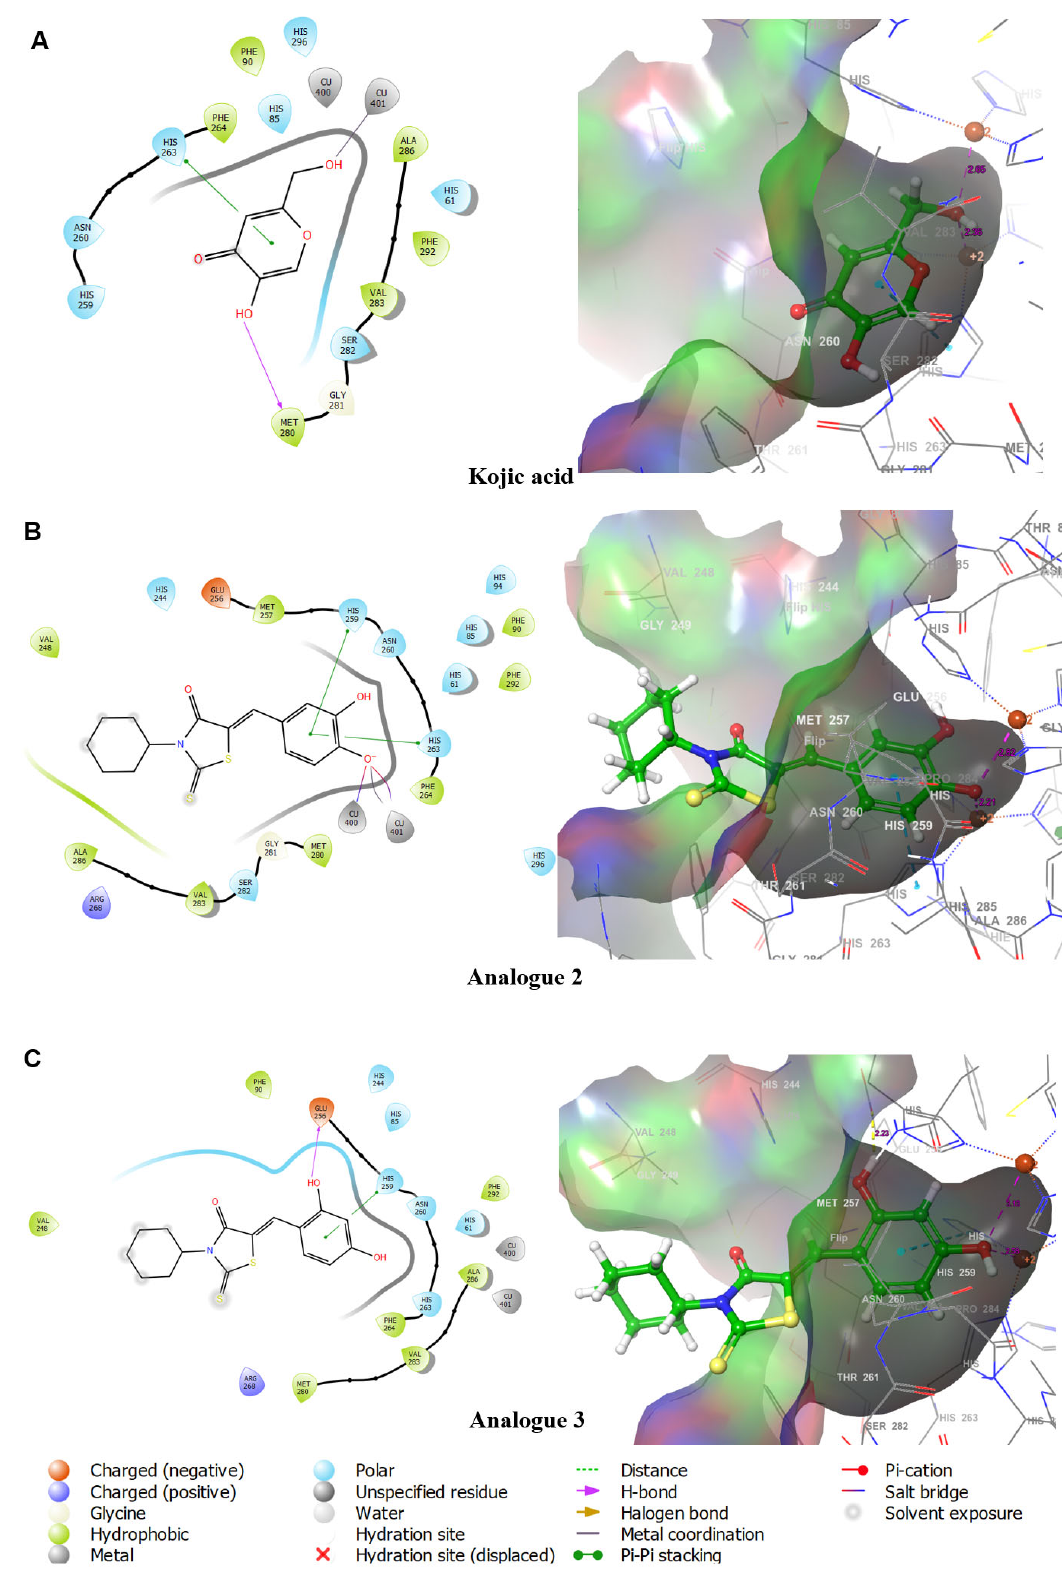
Figure 2. Docking simulations of analogs 2 and 3 and kojic acid with mushroom tyrosinase (PDB ID: 2Y9X) as determined using Schrodinger Suite. Interactions between tyrosinase and kojic acid ( A ) and analogs 2 ( B ) and 3 ( C )) are presented in 2D and